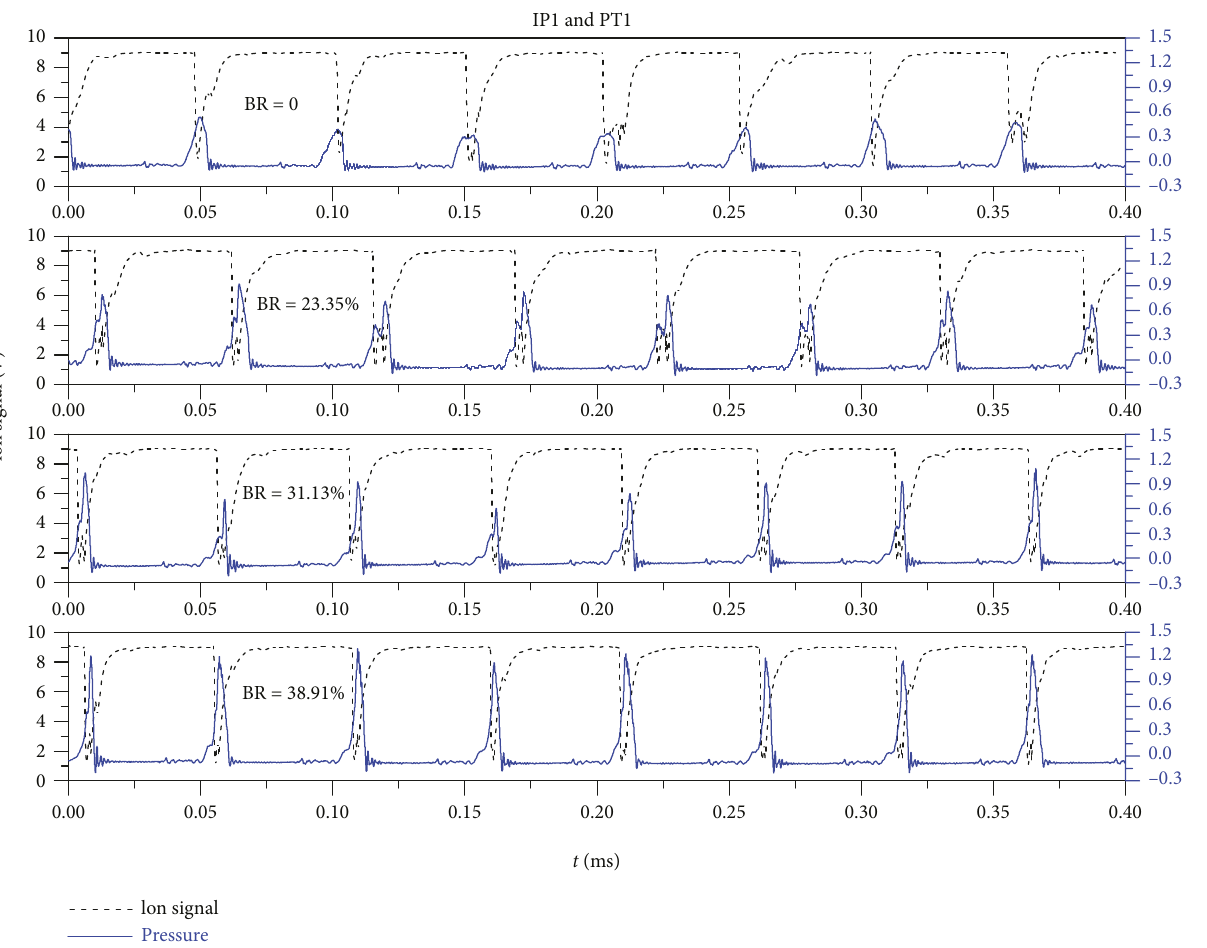
Figure 13: Variation of voltage (ion probe) and pressure signals (pressure sensor) at X = 160 mm, where it is near the exit of the WRC with di ff erent blockage ratio spoilers.